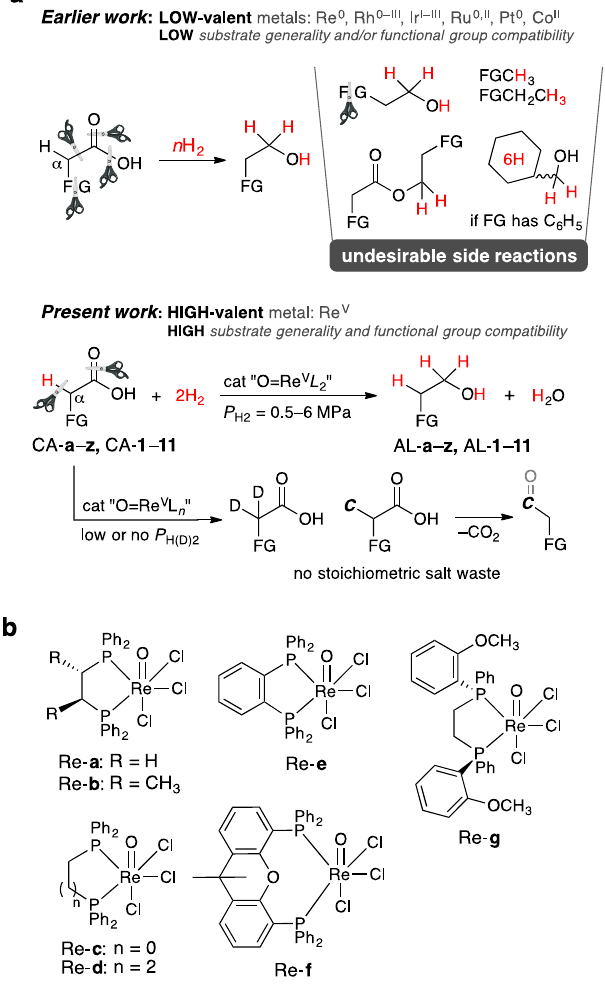
Figure 1. Overview of the present work ( a ). Overcoming the drawbacks of previously reported catalytic systems for the chemoselective hydrogenation of CAs. FG = functional group, L = ligand, C = carbon fragment. ( b) Some Re V = O complexes tested thus far for CA